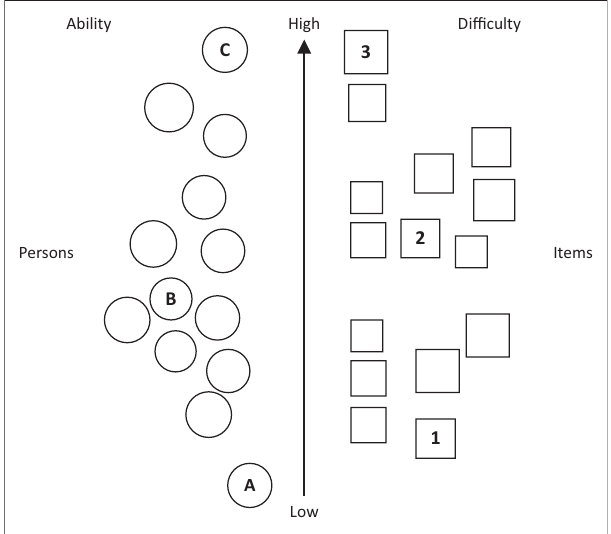
FIGURE 1: Item difficulty and person